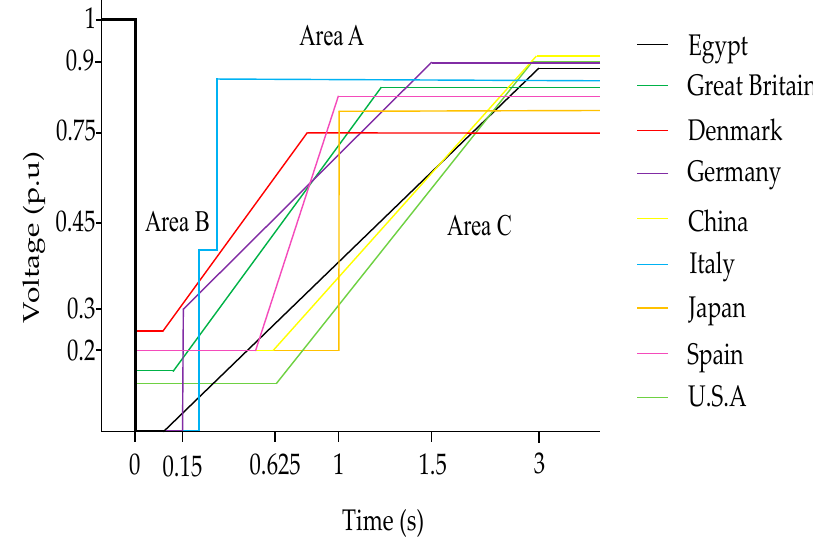
Figure 7. FRT requirements for different countries [35]. Grid codes are enforced on wind power installations to meet reactive power require- ments. When the PCC voltage decreases by more than 10%, as illustrated in Figure 8, the wind farm’s reactive current production should conform to the curve [36]. Equations (17) and (18) show the LVRT calculations.